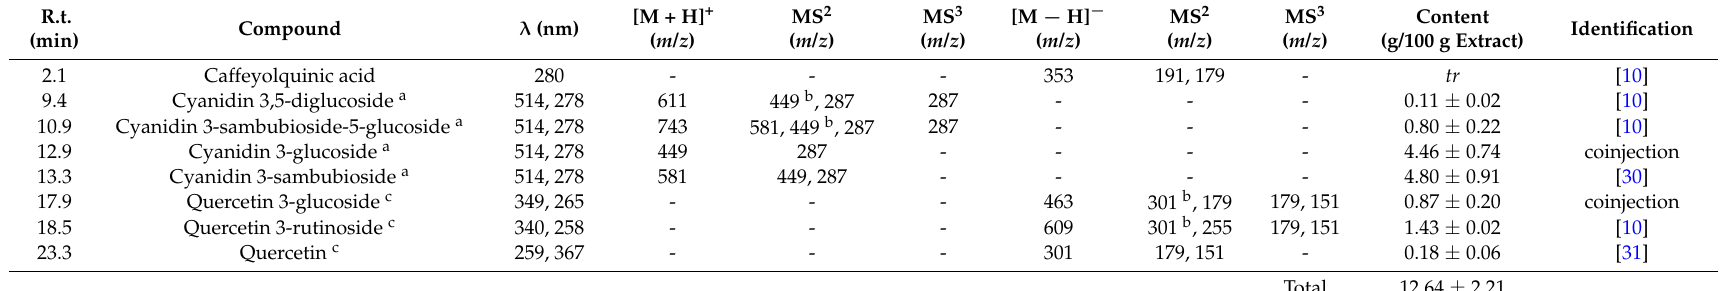
Table 3. Phenolic compounds identified in S. nigra L. berry polar extract and corresponding MS n fragmentation